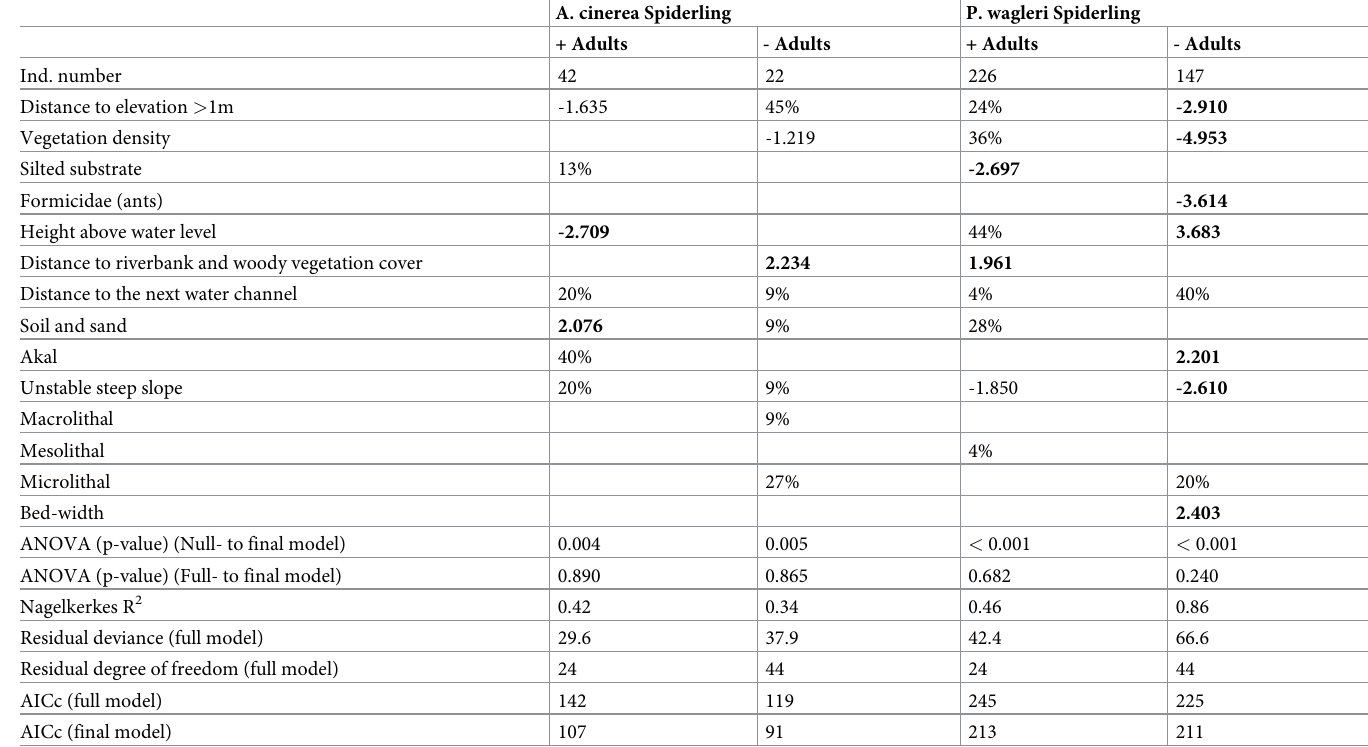
Table 3. Habitat preferences calculated for spiderlings on sample units with and without adult spiders (individuals � 7mm). Numbers for the variables represent the z-value (estimate/ standard error) given by the dredged negative binomial regression. Significant results are given in bold. Percentages represent the relative proportion of occurrences of the variable in competing models with delta AICc < 2